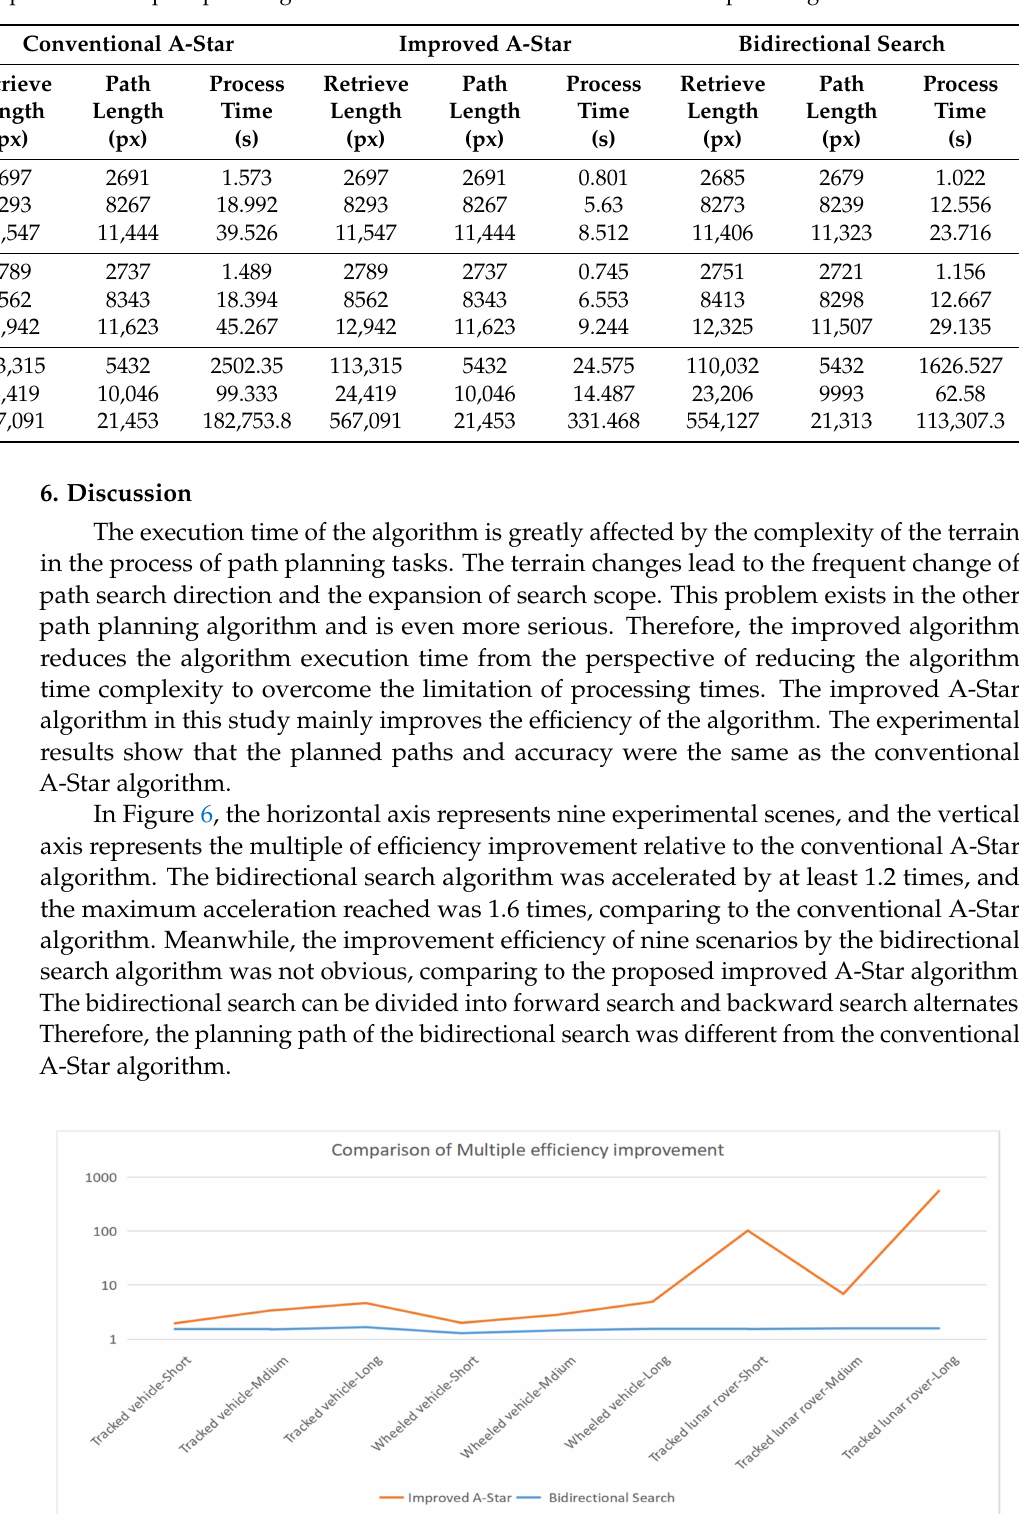
Table 3. Comparison of the path planning of different off-road vehicles with different path lengths.